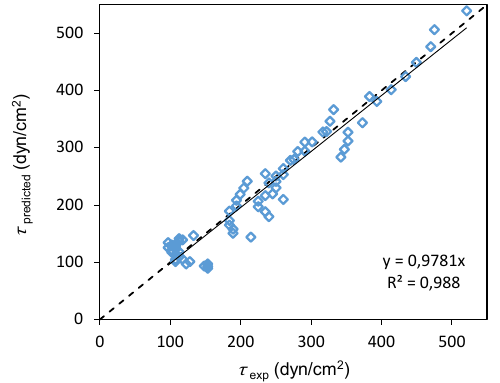
Figure 10: Comparison between the experimental shear stress and the data predicted by the modified Herschel-Bulkley model. Dashed line: graph diagonal; solid line: linear trend of τ predicted vs. τ exp